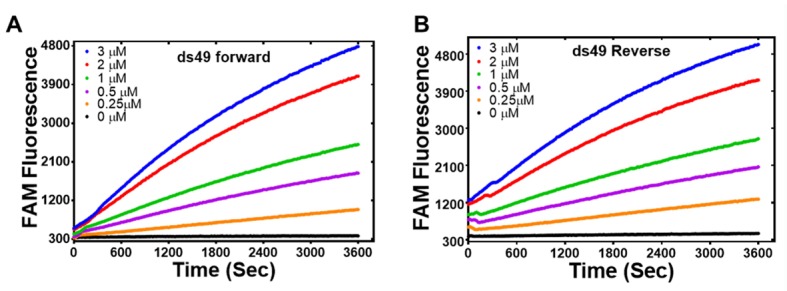
PALB2 strand exchange activity with longer dsDNA.Forward (A) and inverse (B) strand exchange reactions supported by N-DBD at different concentrations ranging from 0.25 μM to 3 μM performed with ss90 and FAM/Dadsyl-labelled ds49.